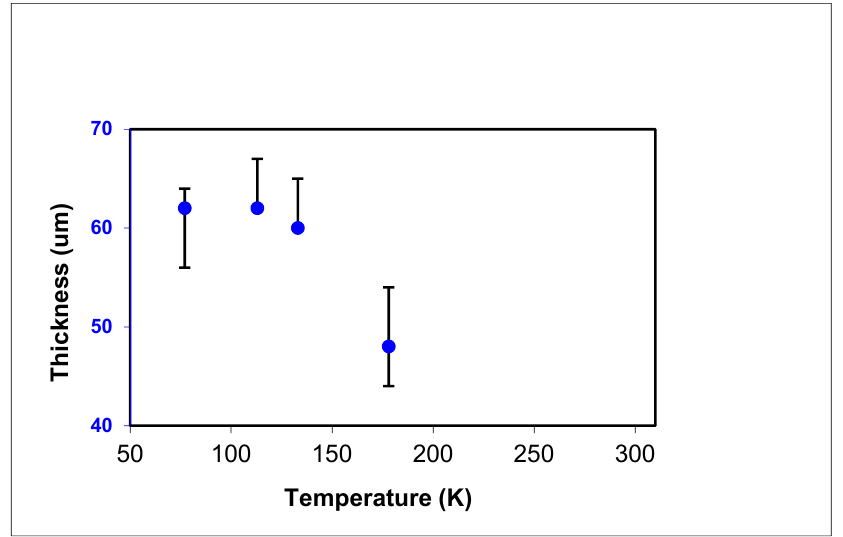
Figure 9. Temperature-dependence of spalling for Si(100). Spalled at various low temperature points. Data points represent thickness in smooth areas. Si error bars denote thickness variation in rough areas (see SEM images on Figure 8).